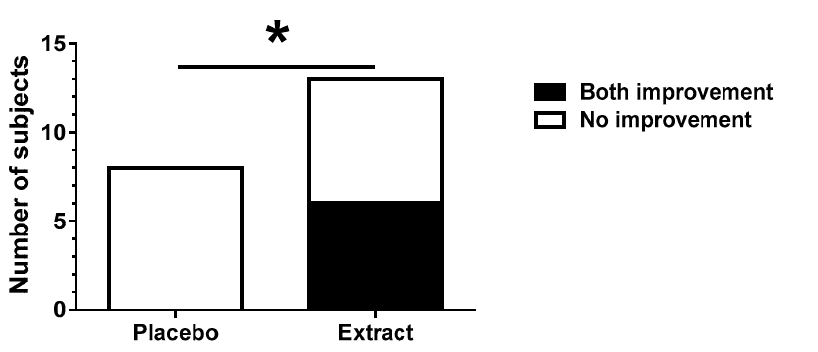
Figure 3. Number of subjects aged >60 years with improvements in the 5 m walking test and two-step test scores (placebo; n = 8, CT extract; n = 13). * p <0.05 (Fisher’s exact test).